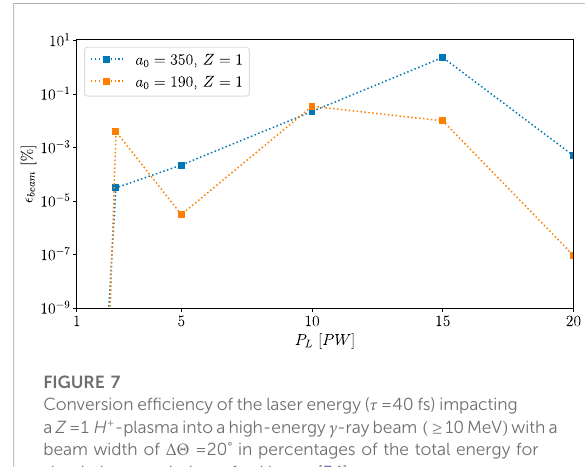
TABLE4TableofquantitiesforaconicaltargetasinTable3butforthe laser pulse duration τ =40 fs.